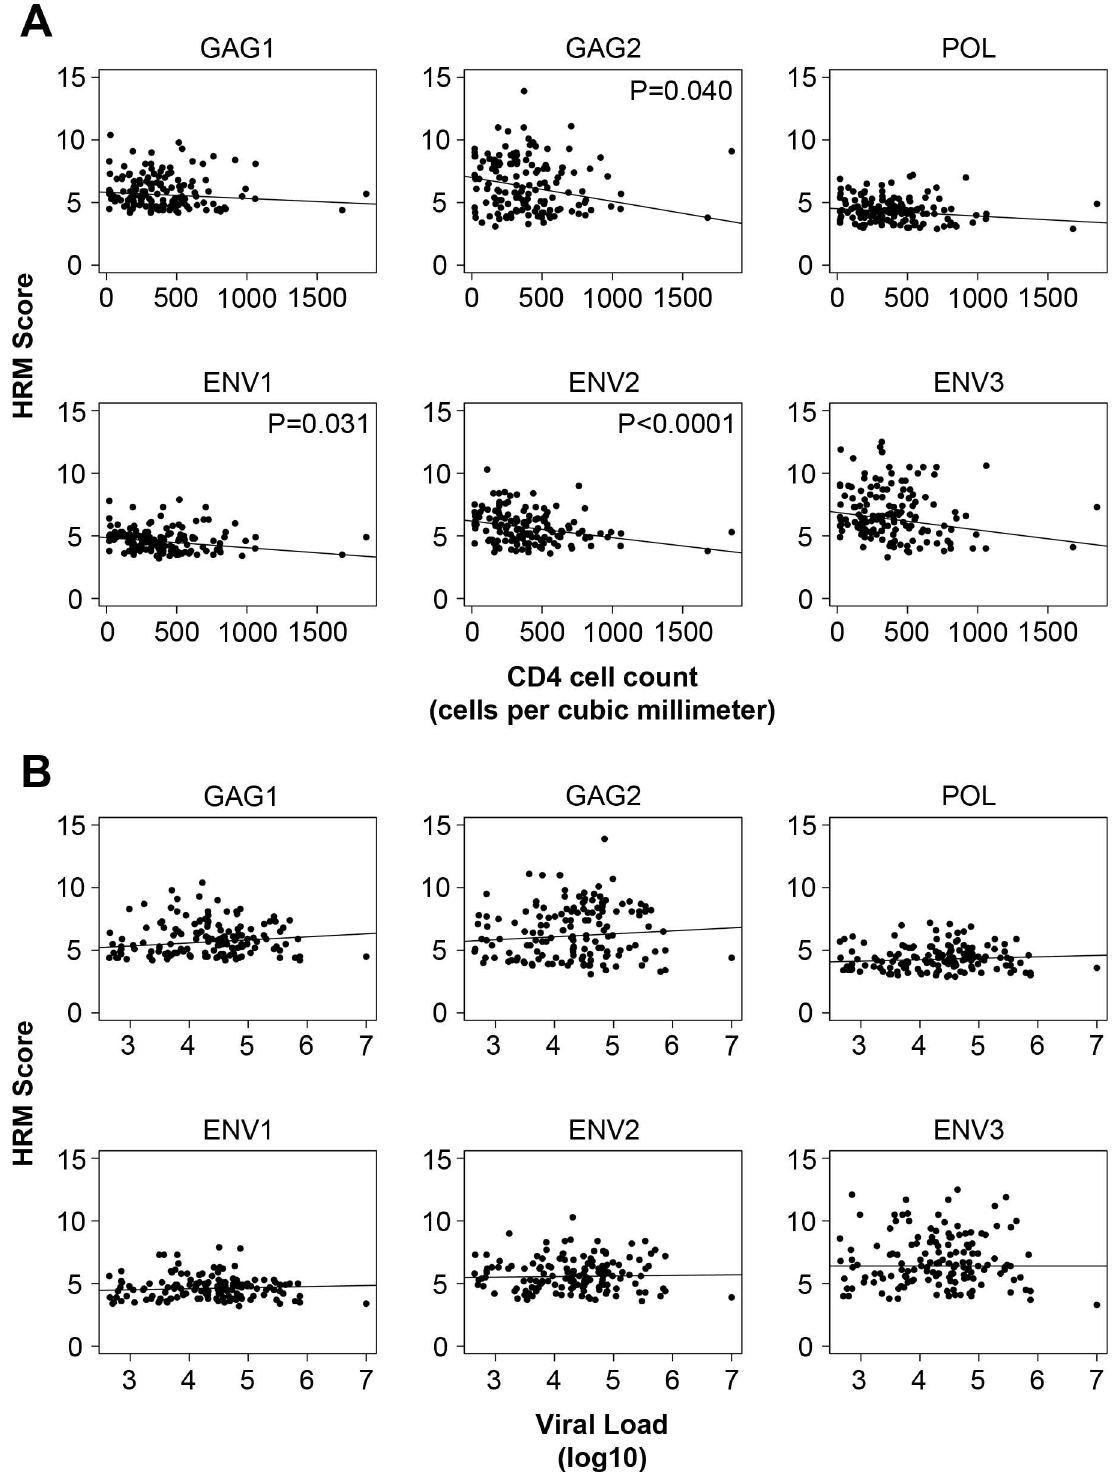
Fig 3. Association of HIV diversity with CD4 cell count and HIV viral load in men who were HIV infected at enrollment. Scatterplots show the relationship betweenhigh resolutionmelting(HRM) score with HIV viral load and CD4 cell count for men who were HIV infected at enrollment; p -values < 0.05 are